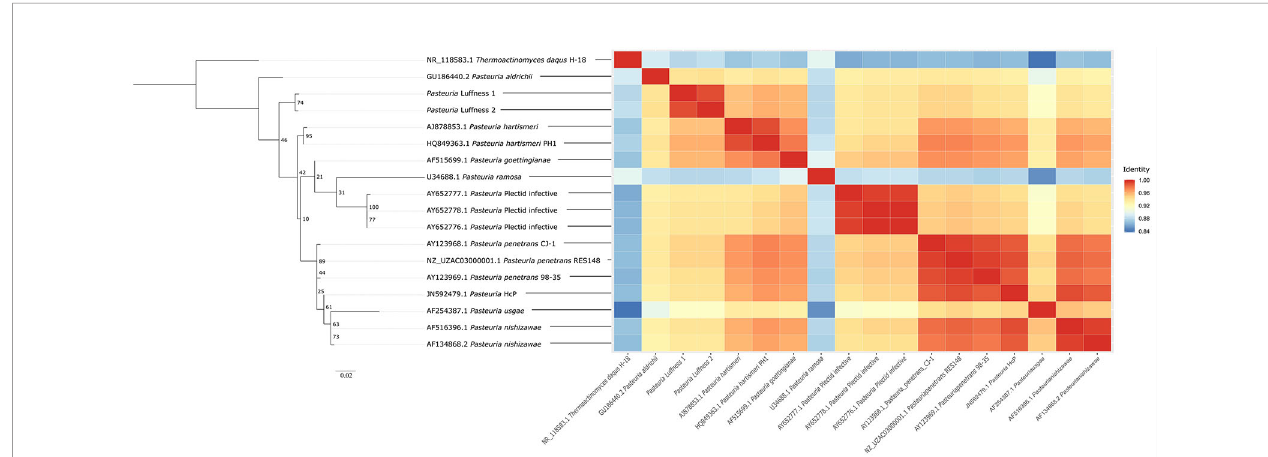
FIGURE 1 | Maximum likelihood phylogeny and pairwise sequence identity heatmap of Pasteuria spp. taxonomic reference sequences used in primer design and Pasteuria spp. ZOTU taxonomic